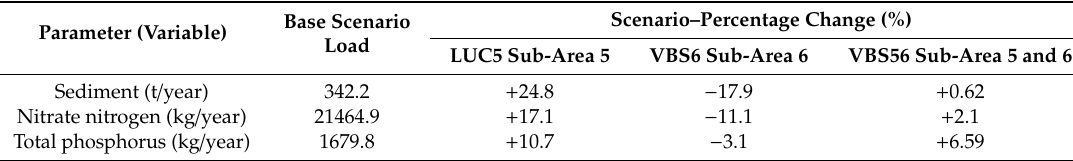
Table 10. Impact of alternative scenarios on the change (%) in average annual sediment load (t / year), total phosphorus load (kg / year), and nitrate nitrogen load (kg / year) at the Kožbanjšˇcek stream catchment main outflow in comparison to the baseline